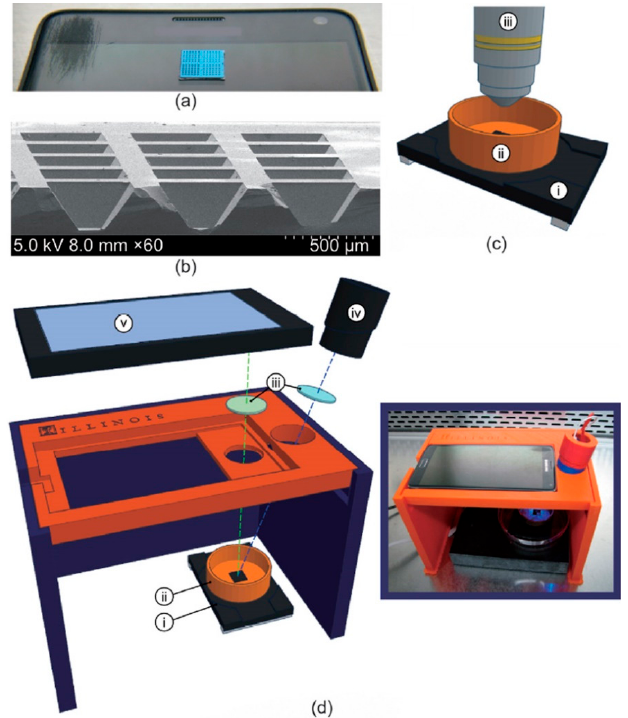
Figure 5. ( a ) Image of 1 cm × 1 cm silicon microchip substrate sitting on a Samsung smartphone. ( b ) Scanning electron microscopy cross-section of 160 µm deep reaction wells. ( c ) Schematic of microchip and heating stage in fluorescence microscope apparatus, including: (i) heating stage, (ii) copper base containing mineral oil, and (iii) fluorescence microscope objective. ( d ) Expanded diagram of smartphone LAMP apparatus, including: (i) heating stage, (ii) copper base containing mineral oil, (iii) wavelength filters placed in front of the LED and smartphone camera, (iv) blue LED light source, and (v) smartphone. (d-inset) Image of apparatus assembled in biosafety cabinet. Reprinted with permissions from ref. [115].